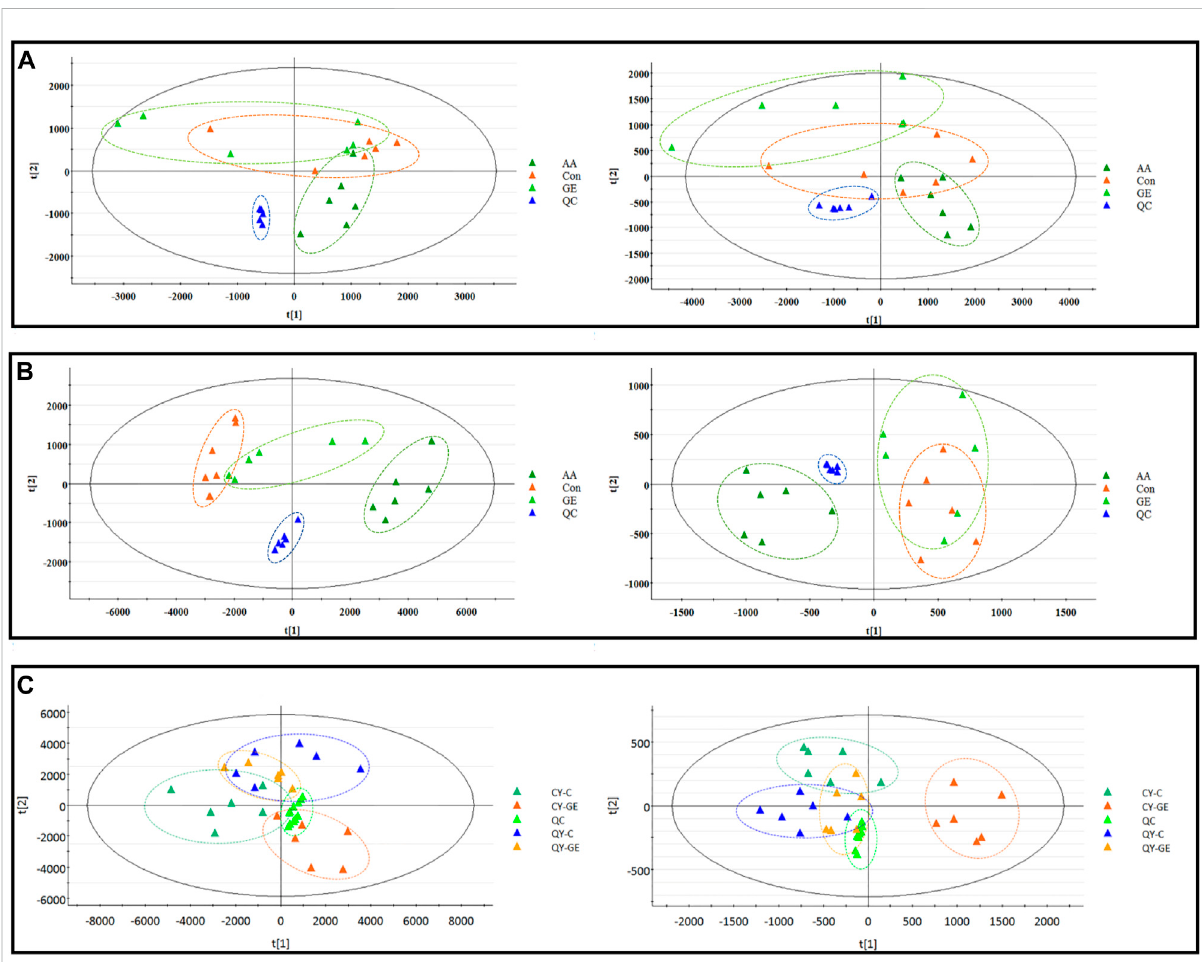
FIGURE 3 | PCA score plots of synovial, serum and MH7A cells extracts in ESI + (left) and ESI − (right) modes. (A) PCA score plots of synovial sample; (B) PCA score plots of serums sample; AA = model group; C = control group; GE = Geniposide treatment group; QC = quality group; (C) PCA score plots